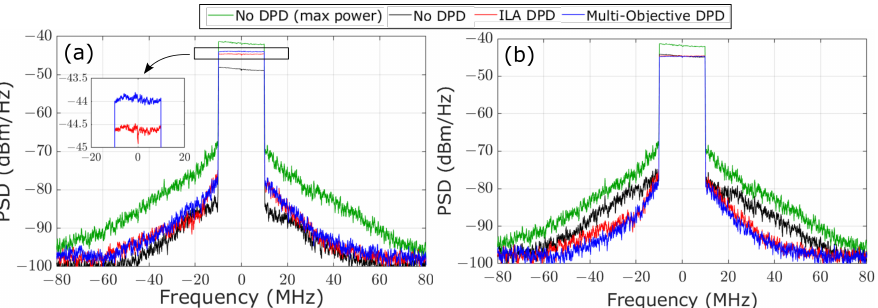
Figure 7. Spectra (not normalized) obtained with the proposed multi-objective optimization (blue), compared with the classical ILA approach (red) and the case without DPD (black). ( a ) same level of ACPR (cid:39) − 33 dB, corresponding to the intercepts of the vertical dashed line in Figure 6a; ( b ) same level of ¯ P OUT (cid:39) 0.7 W, corresponding to the intercepts of the horizontal dashed line in Figure 6a. Green lines show the maximum output power performance without DPD at − 4 dB compression ( ¯ P OUT (cid:39) 1.3 W, ACPR (cid:39) − 27 dB).